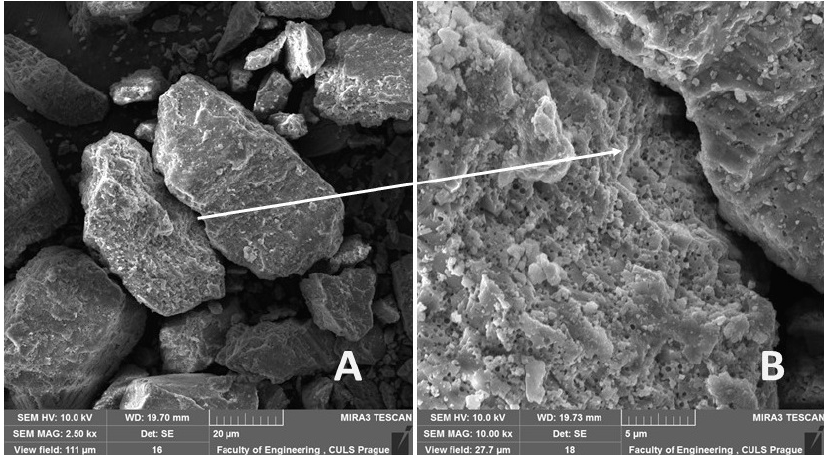
Figure 2. Microparticles of eggshell filler: ( A ): the filler shape and size (MAG 2.50 k×), ( B ): micro porosity on surface of the filler (MAG 10.00 k×).